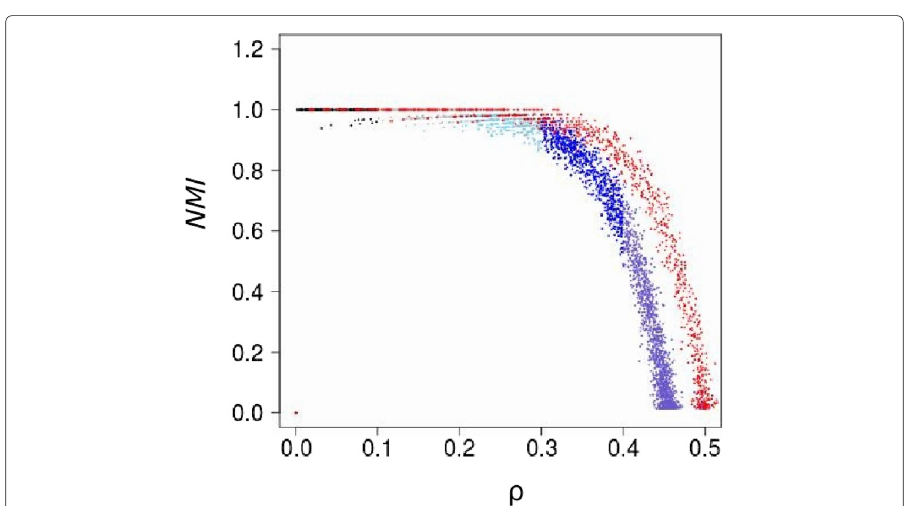
Fig.5 Normalized Mutual Information (NMI) vs ρ for 100 realizations of the system with N = 1000 agents with an underlying network of contacts of Erdos-Renyi of < k > = 12. Red points correspond to the case in which the states of the agents are assigned at random and the G AL is determined from this random